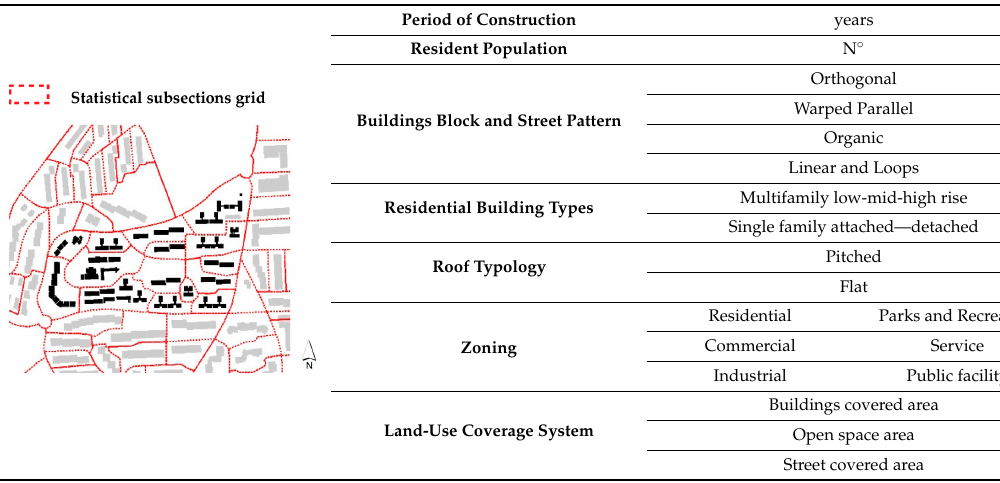
Figure 2. Interactive workflow.